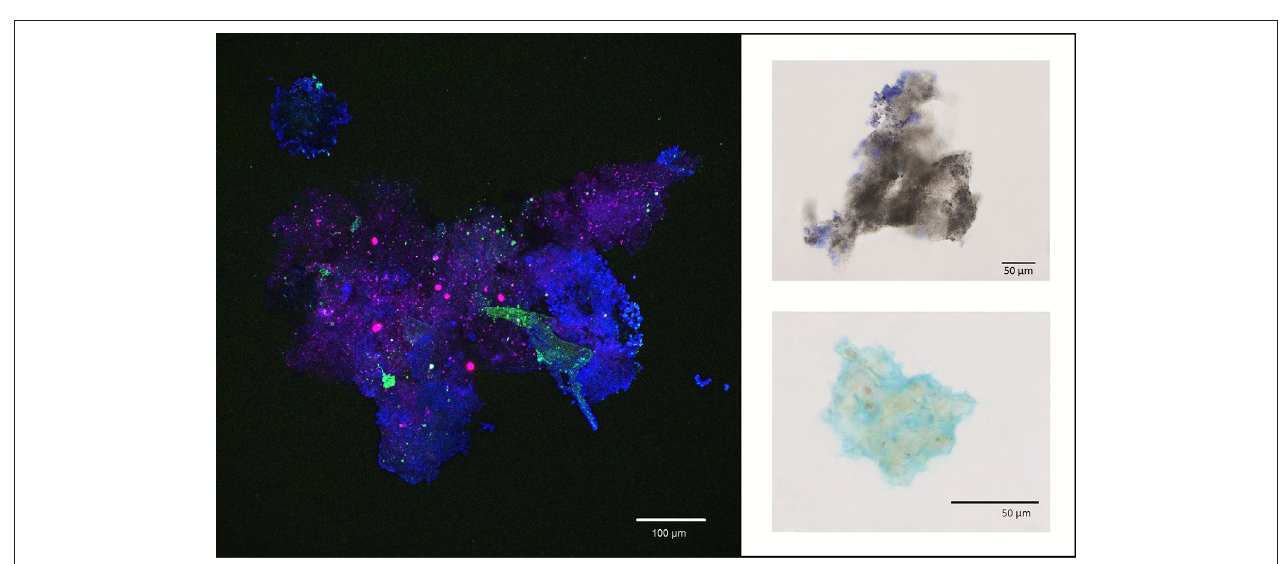
FIGURE 3 | Barplot showing pattern of CSP totalArea :TEP totalArea ratio over depth for different stations. Y-axis inverse, with logarithmic scaling.